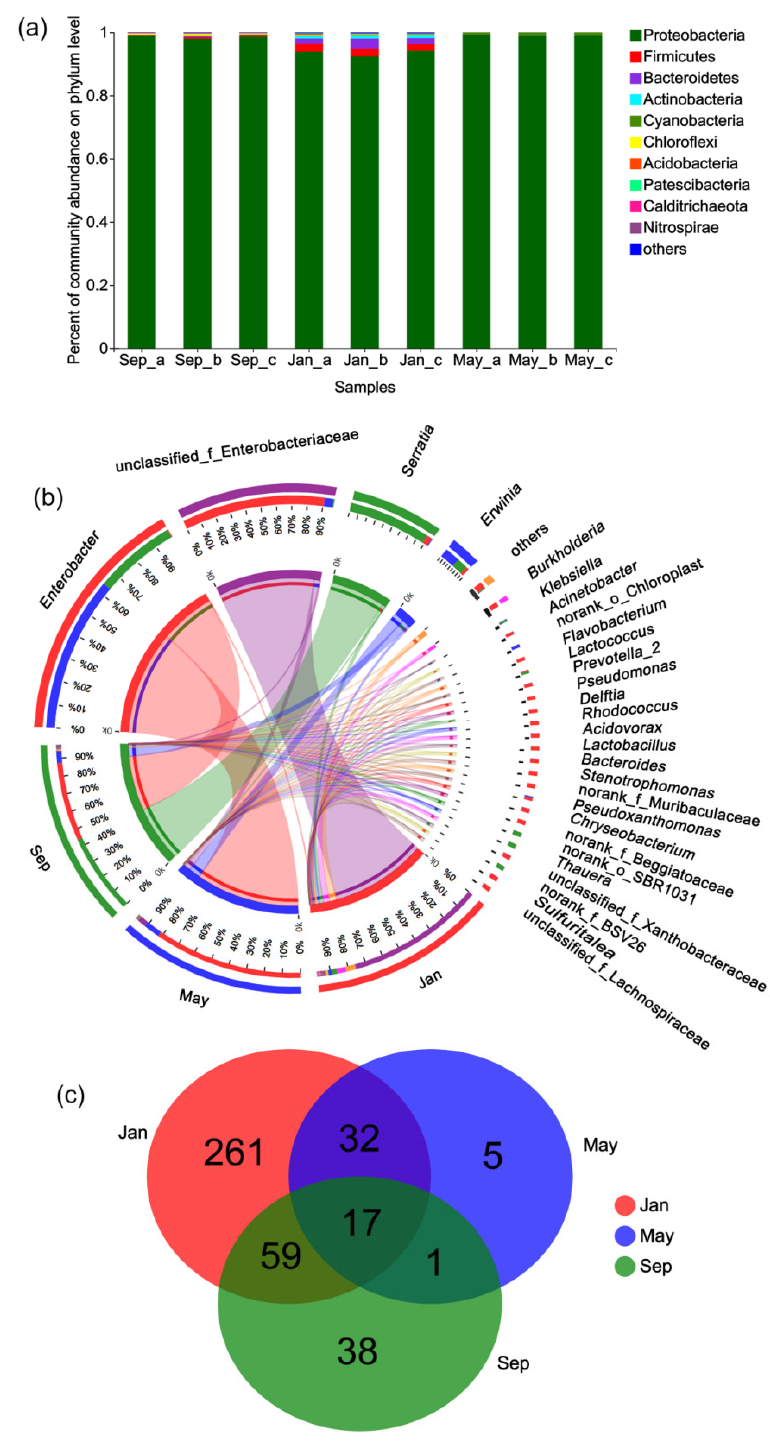
Figure 2. The diversity of the larval RTB gut microbiome across different seasons showing data for the bacterial communities. ( a ) The gut microbiota composition at the phylum level. ( b ) The gut microbiota composition at the genus level. ( c ) The numbers of common and unique genera found in the larvae collected in different seasons.